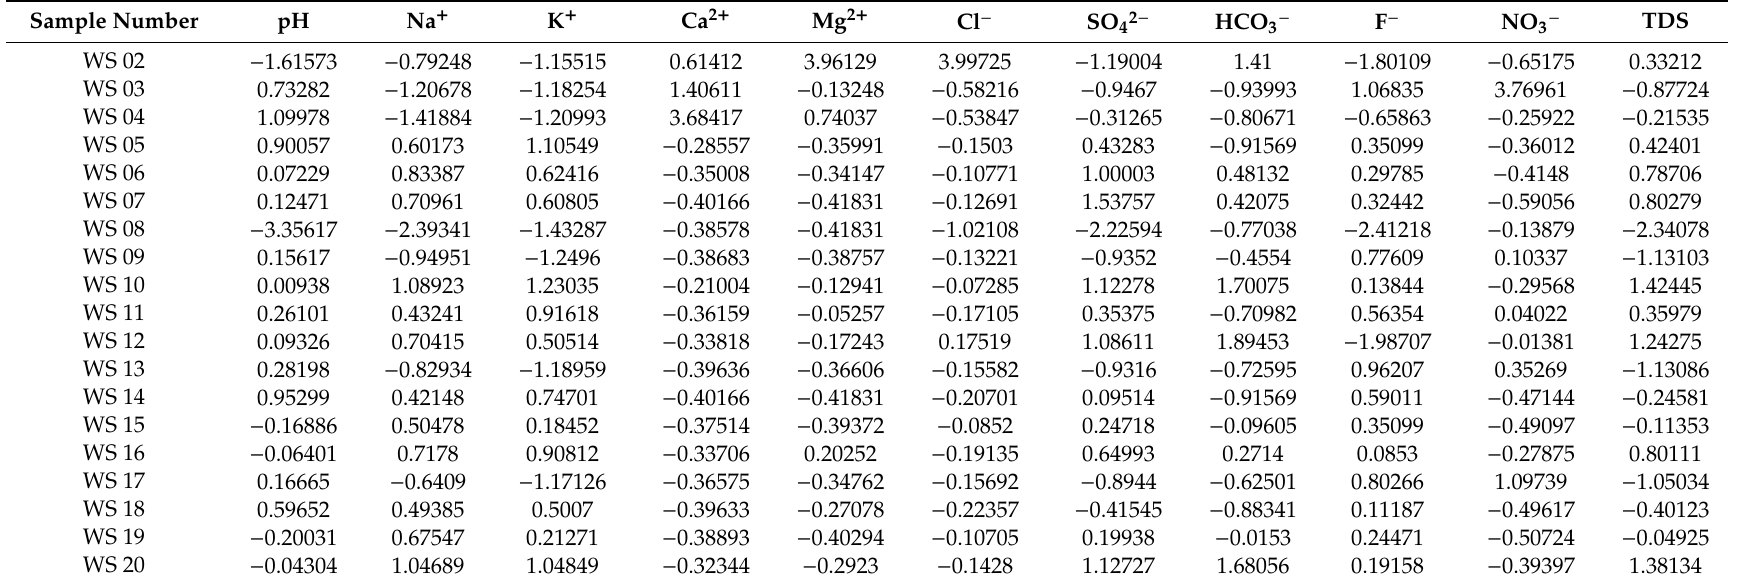
Table 2. Results of dimensionless standardization of water